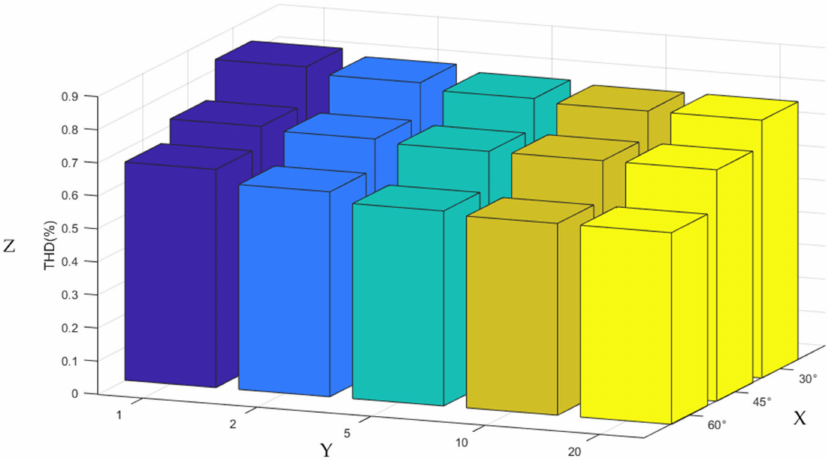
Figure 9. Model of the grid connected PV